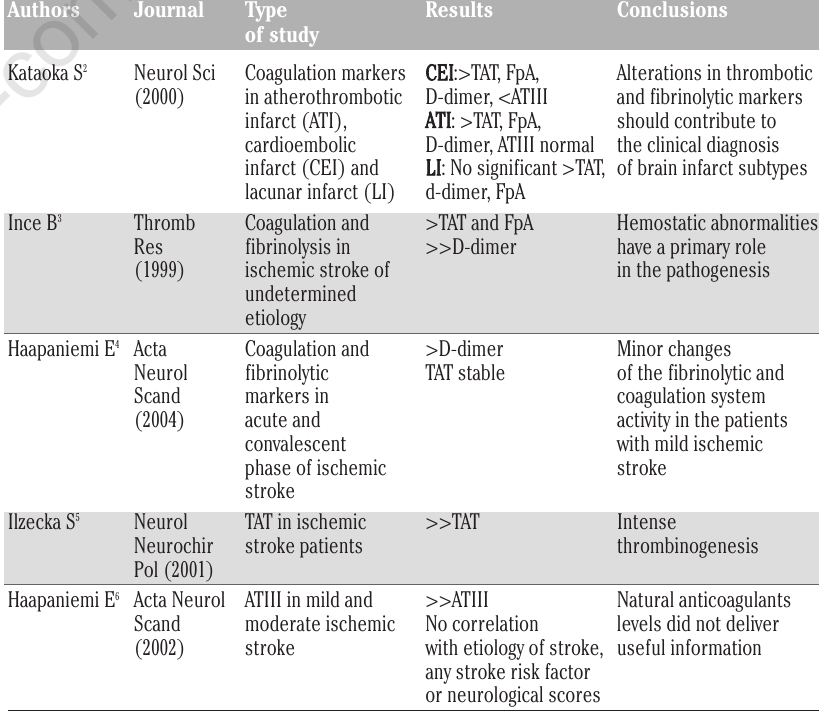
Figure 1. Schematic rappresentation of activation of coagulation and inflammation during cerebral ischemia. Exposure of tissue factor-bearing inflammatory cells to blood results in thrombin generation and subsequent fibrinogen to fibrin conversion. Simultaneously, activa- tion of platelets occurs, both by thrombin and by exposure of collagen (and other subendothe- lial platelet-activating factors) to blood. Binding of tissue factor, thrombin, and other activat- ed coagulation proteases to specific PARs on inflammatory cells may affect inflammation by inducing release of proinflammatory cytokines (such as IL-18), which will subsequently fur- ther modulate coagulation and fibrinolysis. Fibrinogen and fibrin can directly stimulate expression of proinflammatory cytokines on mononuclaer cells and induce production of chemokines by endothelial cells and fibroblast. The effects of fibrin (and fibrinogen) on mononuclear cells are at least in part mediated by toll-like receptors (TLR2-4), which are also the receptors of endotoxin. S100 b at supraphysiological concentration can stimulate astro- cytes and microglia to produce proinflammatory cytokine. Coagulation pathways are indicat- ed by straight arrows, inflammatory mechanisms by dashed arrows. Table 1. Thrombin-antithrombin III complex in